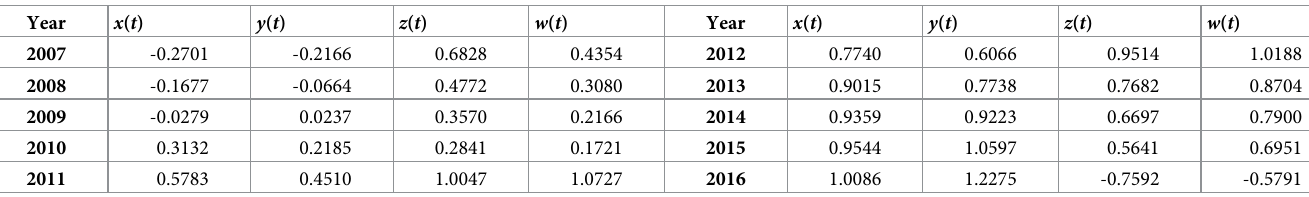
Table 2. Experimental values for x ( t ), y ( t ), z ( t ), and w ( t